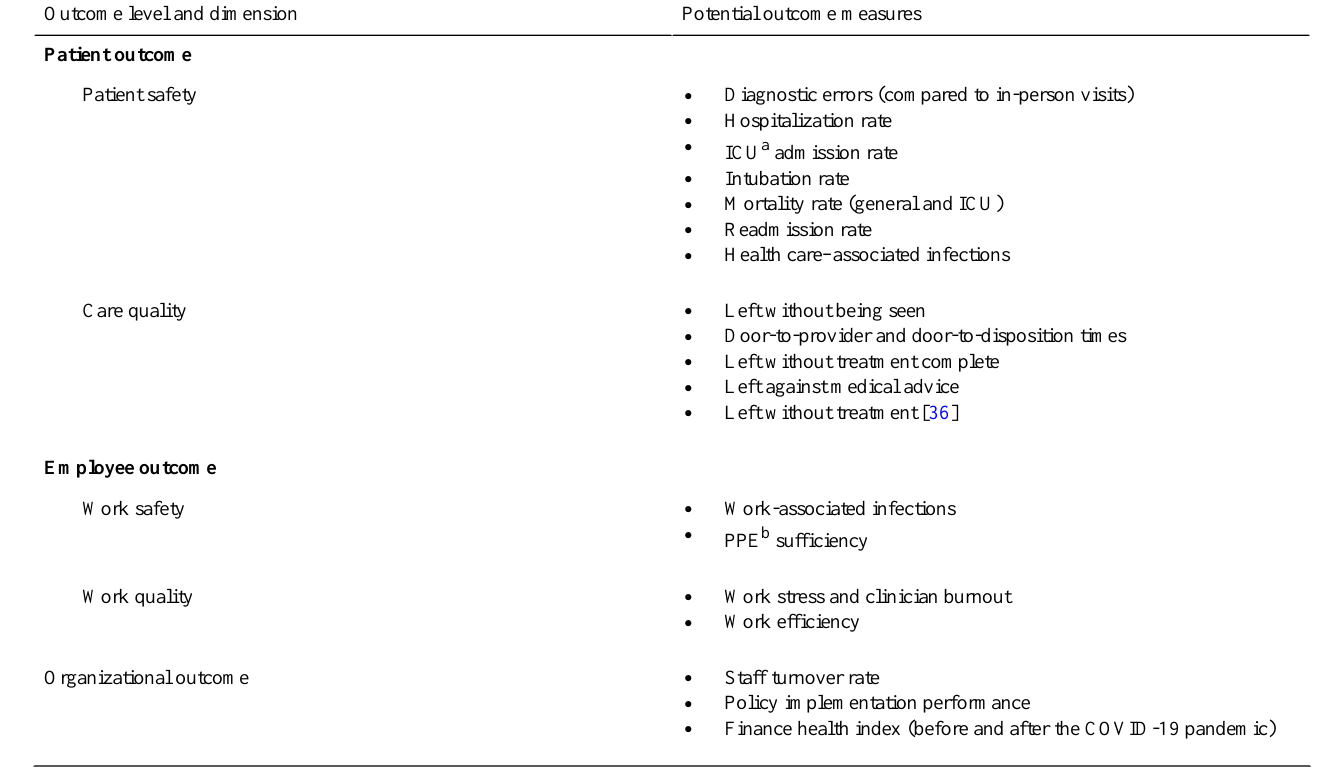
Table 2. Potential outcome measures of telehealth-enabled